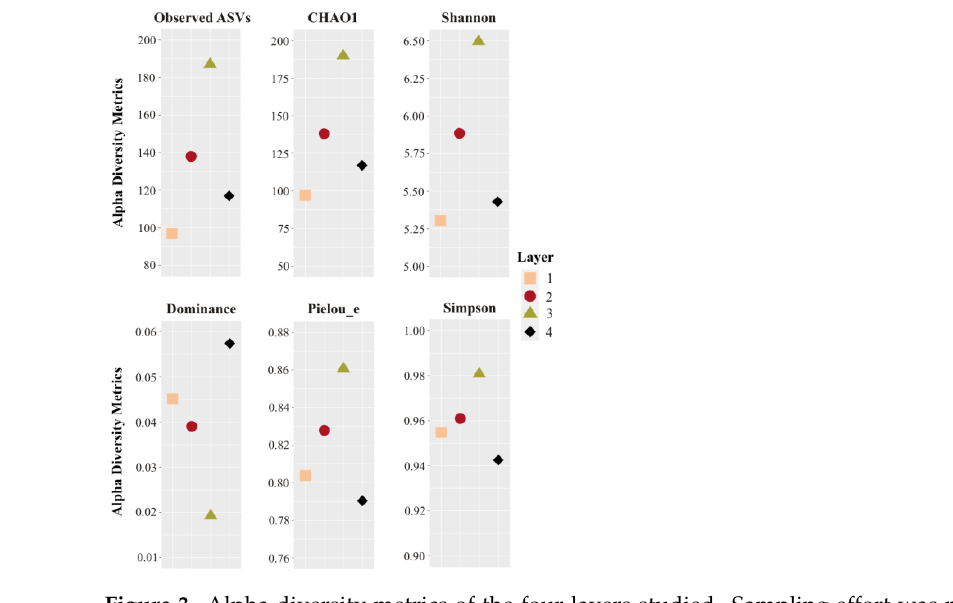
Figure 3. Alpha diversity metrics of the four layers studied. Sampling effort was normalized at 3250 reads per sample. ASVs: amplicon sequence variants.